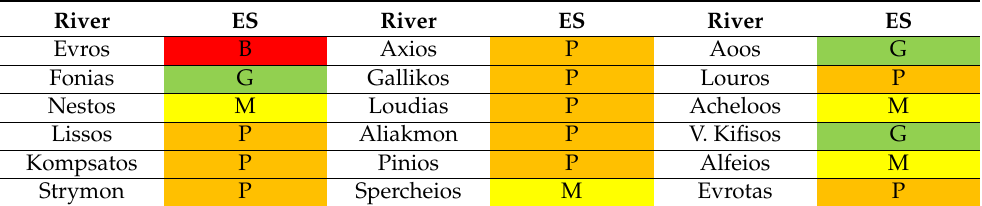
Table 2. ES of the examined rivers near their outflows using C-P, biological (macroinvertebrates, fish,